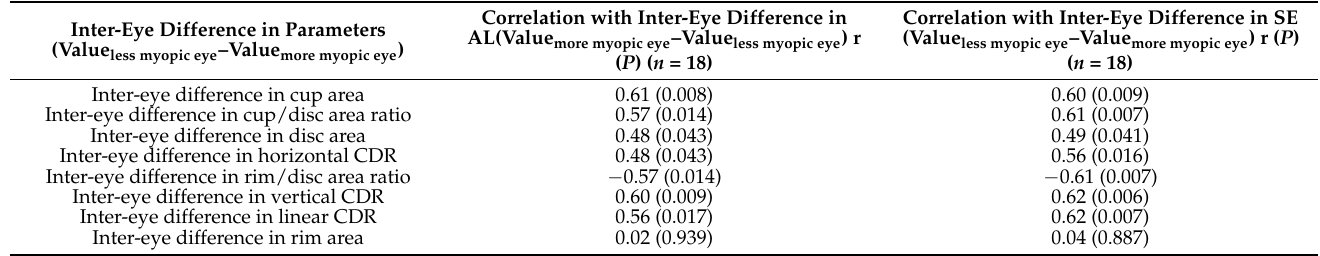
Table 3. Correlations between inter-eye differences in ONH parameters and SE/AL (Pearson correlation).